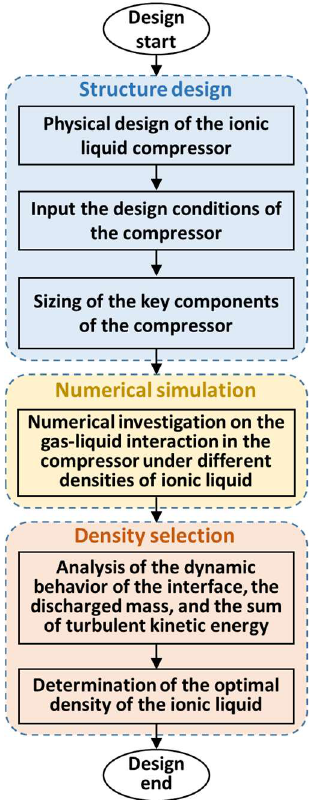
Figure 1. Methodology of density selection for the hydrogen compressor design.